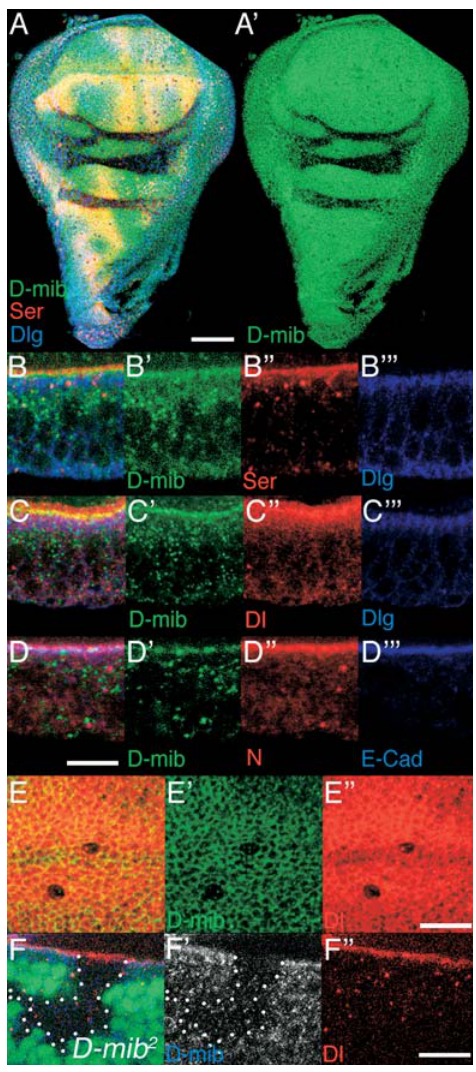
Figure 3. D-mib Co-Localizes with Dl and Ser at the Apical Cell Cortex (A and A 9 ) D-mib (green) is detected in all cells of the wing imaginal disc. In (A), Ser is in red and Discs-large (Dlg) is in blue. (B–D 999 ) D-mib (green in B, B 9 , C, C 9 , D, and D 9 ) co-localized with Ser (red in [B and B 99 ]), Dl (red in [C and C 99 ]), N (red in [D and D 99 ]), and E-Cadherin (E-Cad; blue in [D and D 999 ]) and was found apical to Discs-large (Dlg; blue in [B, B 999 , C, and C 999 ]) in notum cells located at the edges of the wing discs. (E–E 99 ) D-mib (green in [E and E 9 ]) co-localized with Dl (red in [E and E 99 ]) at the apical cortex of wing pouch cells. (F–F 99 ) D-mib staining at the apical cortex (blue in [F and F 9 ]) was not detected in D-mib 2 mutant clone (marked by loss of nuclear GFP staining; green in [F]). Loss of D-mib activity has no detectable effect on the apical accumulation of Dl (red in [F and F 99 ]). Bar is 50 l m for (A and A 9 ) and 10 l m for (B–F 99 ). DOI: